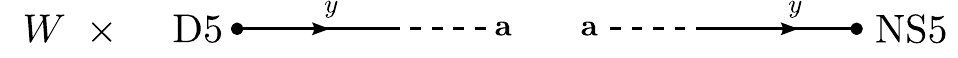
Figure 4 . We can stretch and cut the interval I to factorize the partition function on W (cid:2) I into products of partition functions in two half-spaces W (cid:2) R + . The partition functions in the left and the right half-space, respectively, are Z D5